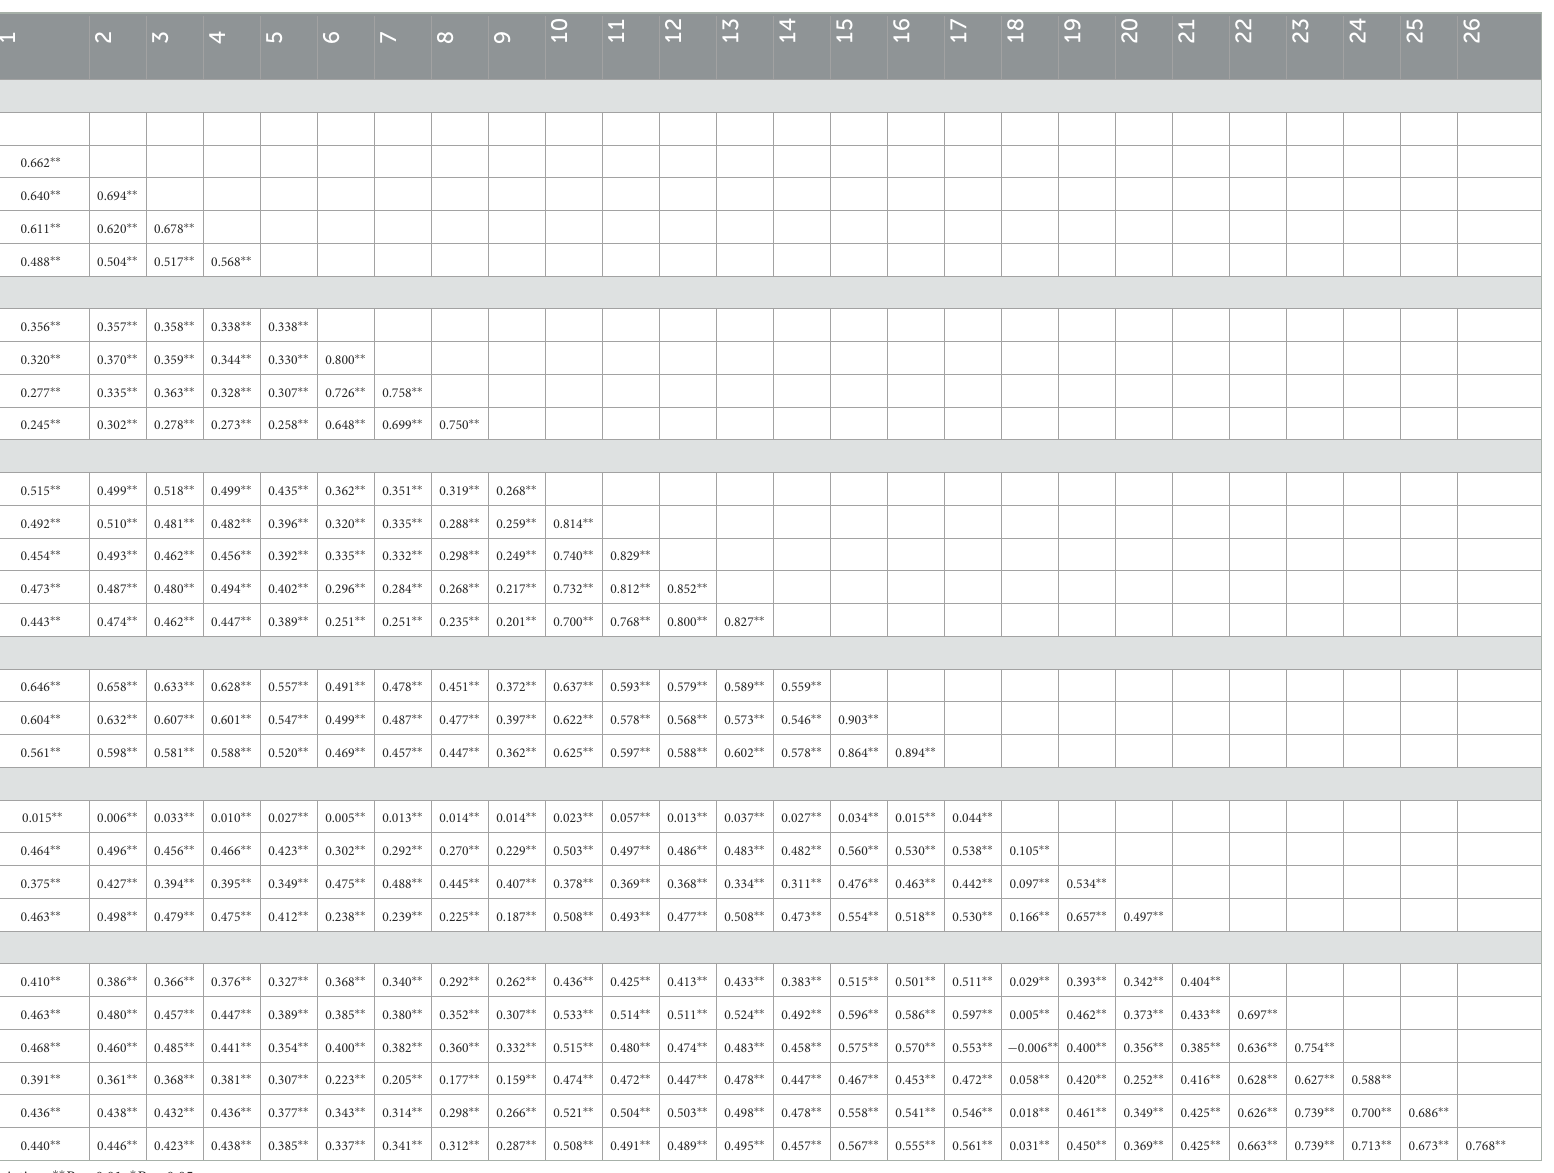
TABLE 2 Descriptive statistics and correlations of the main study